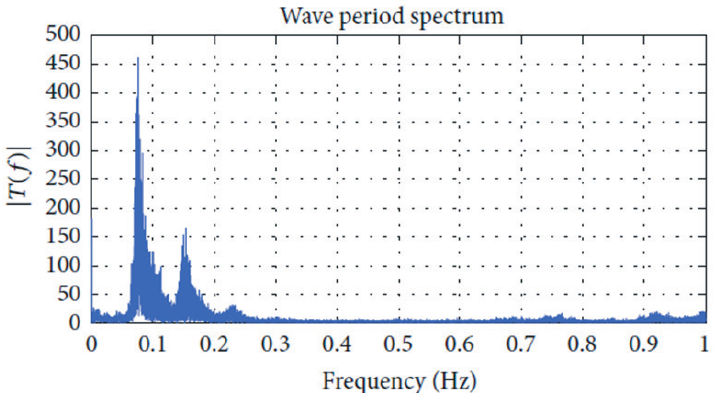
Figure 13. Representative spectral analysis of the waves at the site Mutriku on 12 May 2014